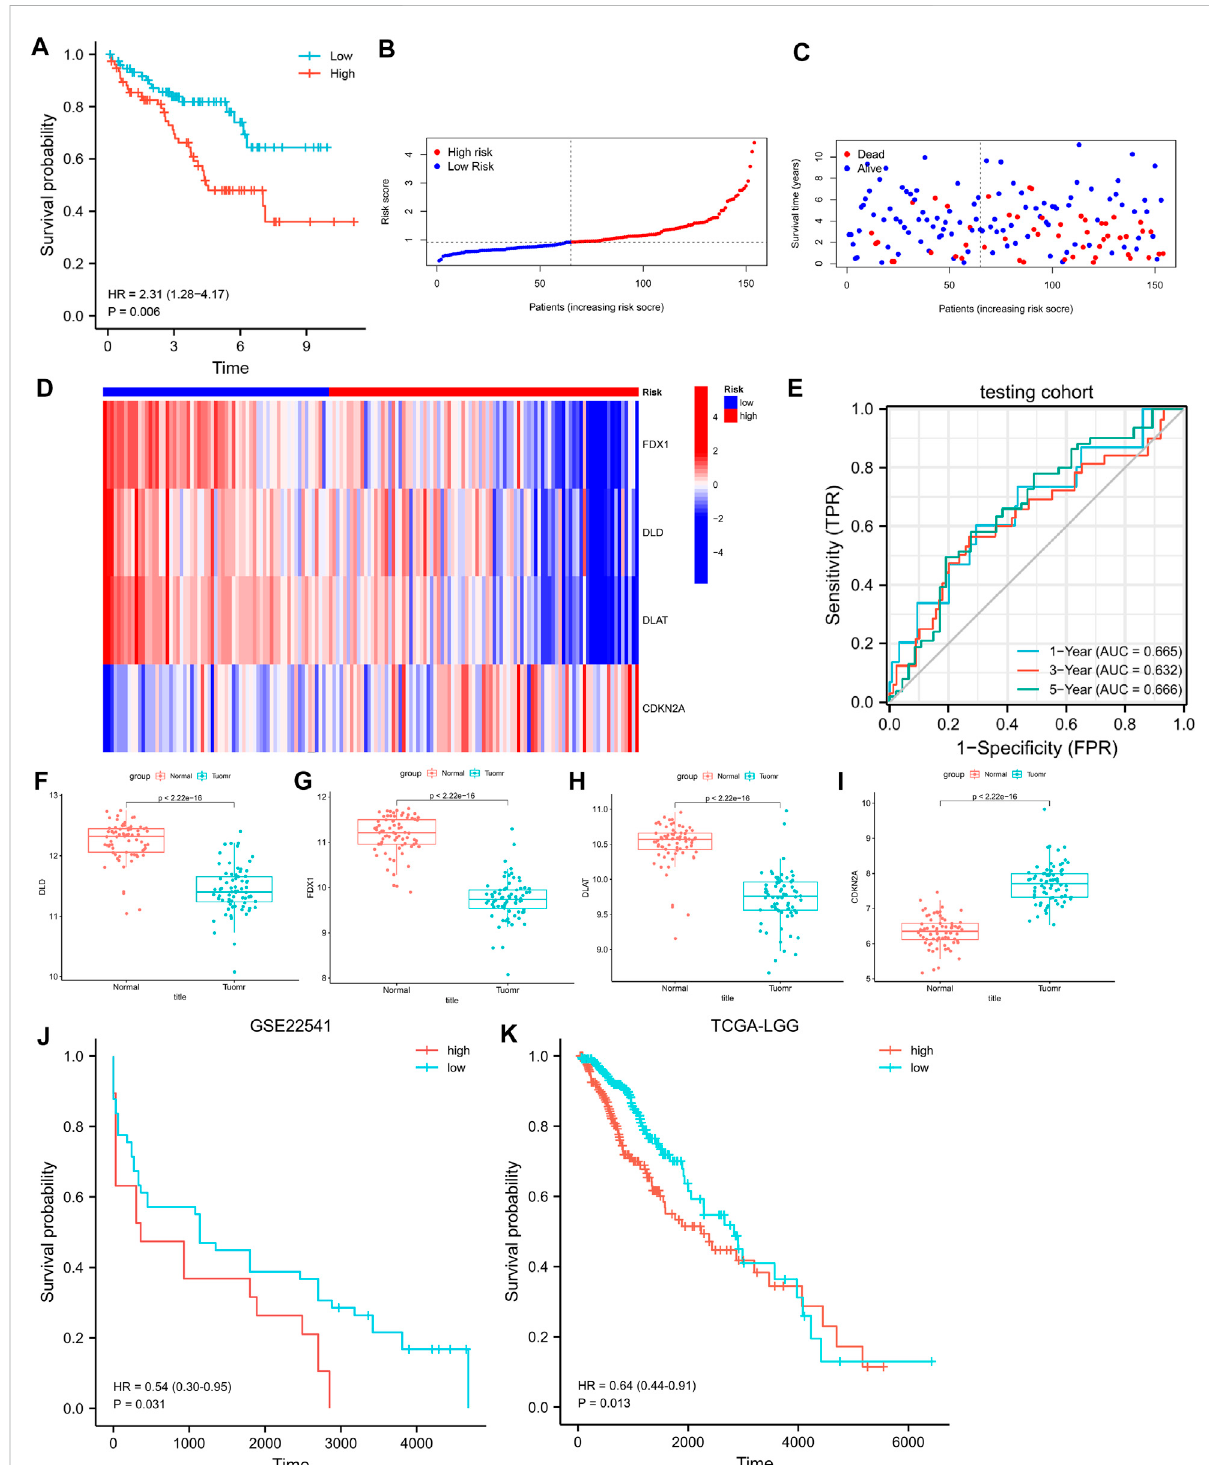
FIGURE 4 (A) K-M curves for OS in the testing cohort. (B – D) The risk score, survival status, and heatmap of 4 CRGs in the testing cohort. (E) Time- dependent ROC curves for OS in the testing cohort. (F – I) Differential expression of FDX1 , DLD , DLAT , and CDKN2A in the GSE53757 dataset. (J) K-M curves for PFS in the GSE22541. (K) K-M curves for OS in the